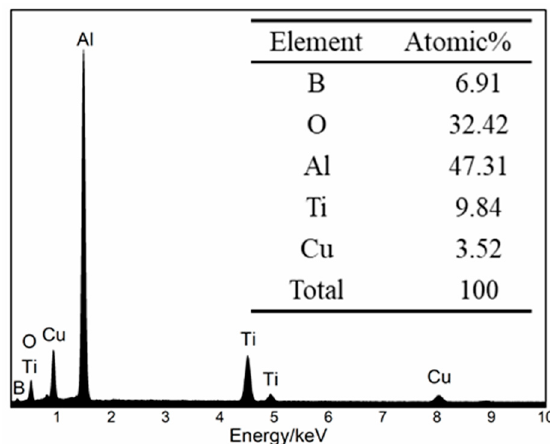
Figure 9. Energy dispersive spectroscopy (EDS) analysis of the TiB 2 particle (white point in Figure 8f) of TiB 2 /2A14